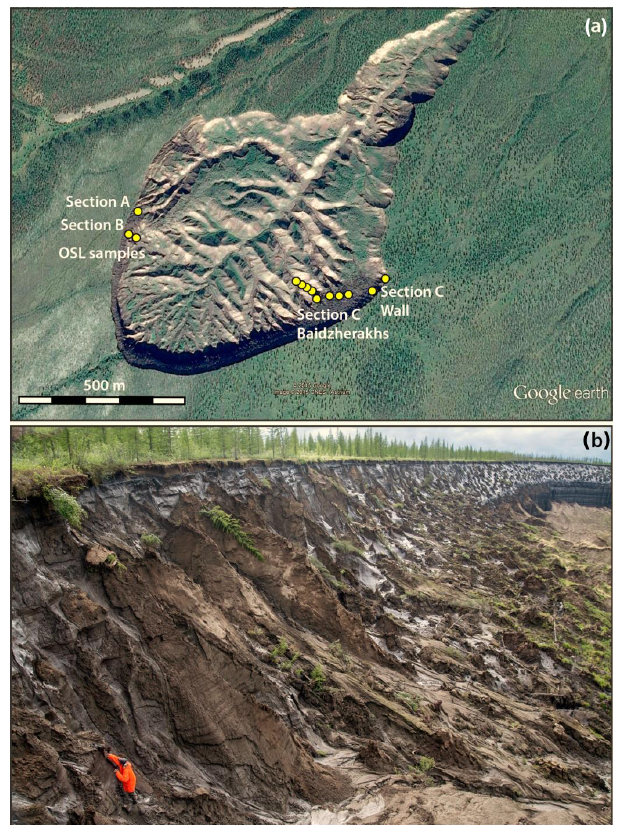
Figure 4. (a) Location of the studied sections in the Batagay mega-slump. Modified from Google Earth 7.1.2.2041. Batagay region, Russia, 67 ◦ 34 (cid:48) 41.83 (cid:48)(cid:48) N, 134 ◦ 45 (cid:48) 46.91 (cid:48)(cid:48) E, 4 July 2013, viewed 25 April 2016, http://www.google.com/earth. (b) Southeast- ern slope of the thaw slump, section C during sampling. Note person for